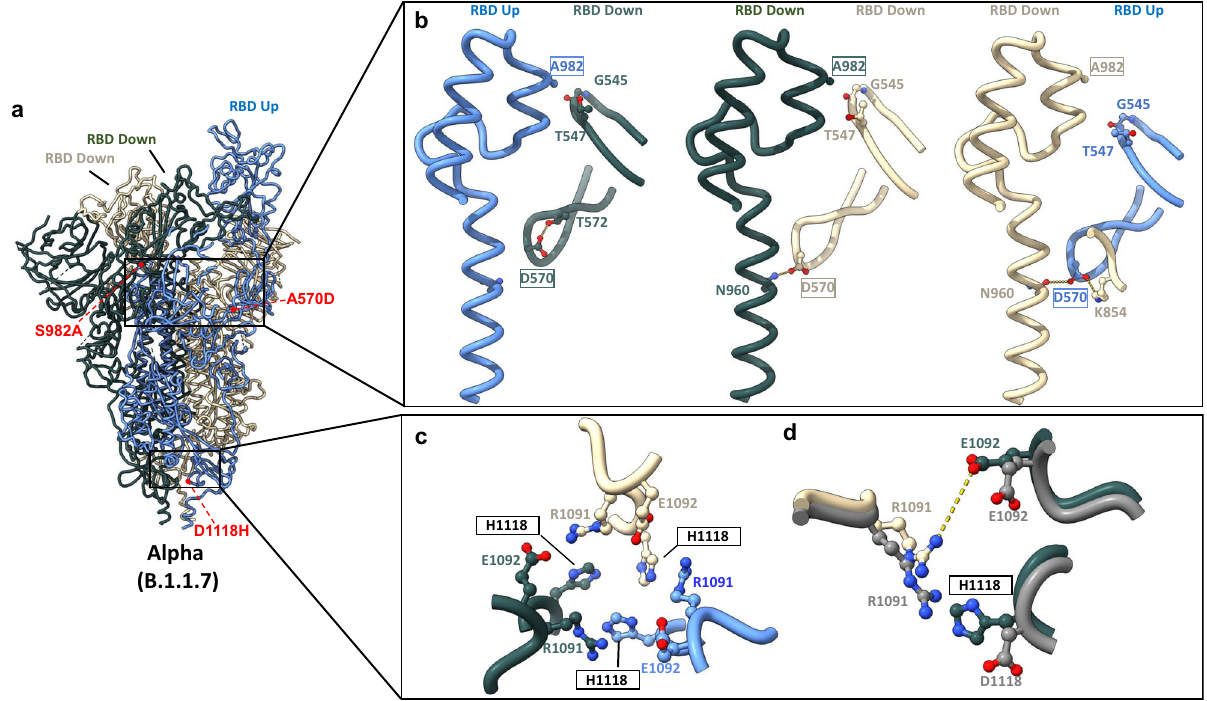
Fig. 4 | Alpha variant S protein mutations resultin structural changesat inter- protomerinterfaces.a GlobalmodeloftheAlphavariantSproteinwithoneRBDin the “ up ” conformation(blue)andtwoRBDsinthe “ down ” conformation(beigeand gray). Relevant mutations at inter-protomer interfaces are highlighted in red. b Modulation of inter-protomer contacts by mutations S982 → A and A570 → D between protomers with differential RBD conformations. c , d Impact of the